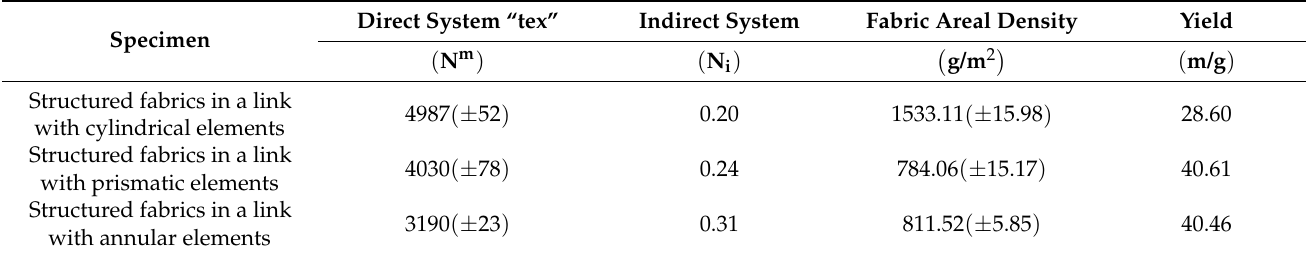
Table 4. Fineness and fabric areal densities of 3D printed fabric specimens.